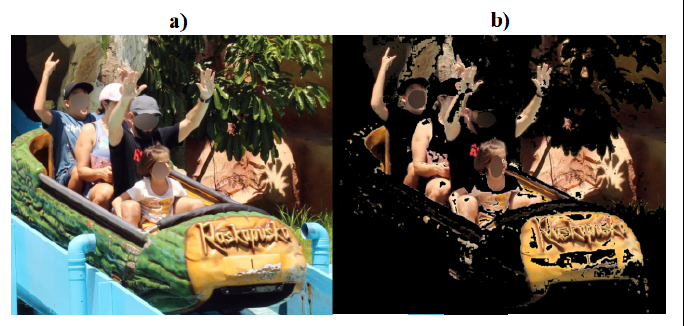
Figure 6. Example image with skin-like pixels in clothing and background regions: ( a ) original image and ( b ) image without non-skin